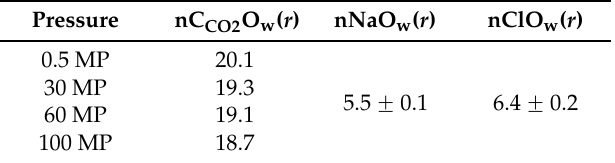
Table 2. The coordination numbers for nC CO2 O w ( r ), nNaO w ( r ), and nClO w ( r ).